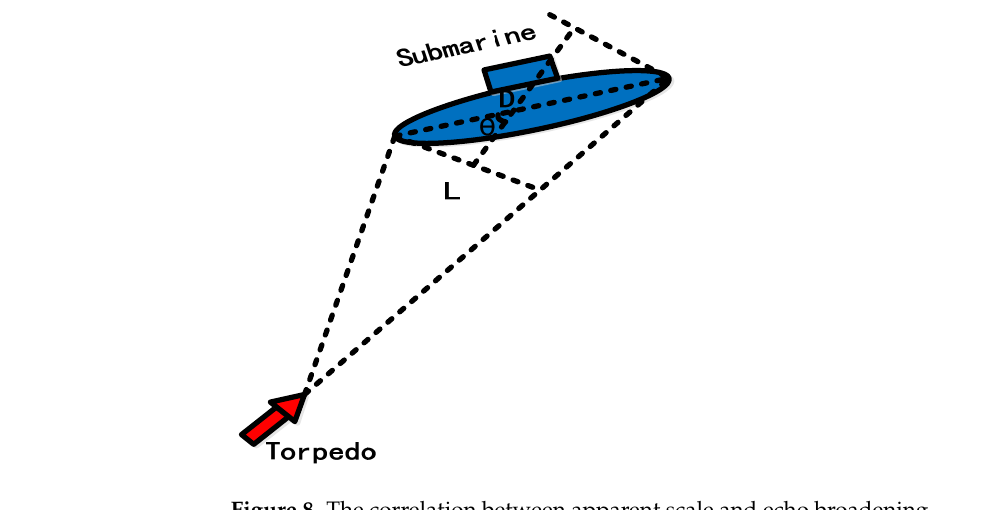
Figure 8. The correlation between apparent scale and echo broadening.